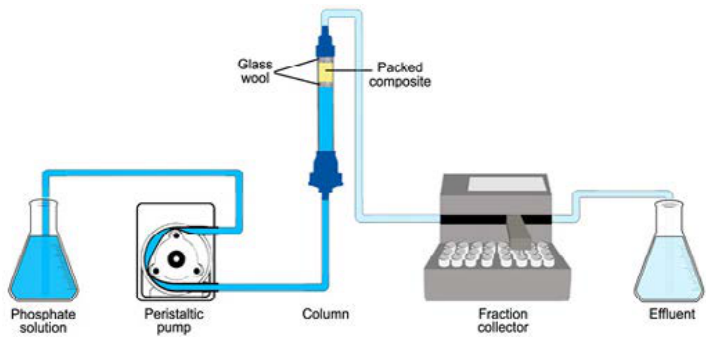
Fig. 1: Schematic diagram of lab-scale fixed-bed column adsorption system